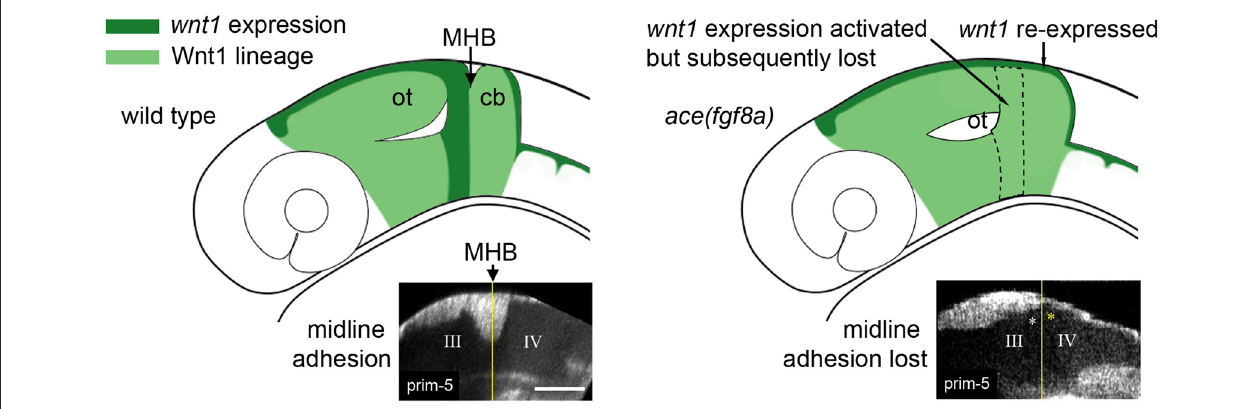
FIGURE 3 | Adhesion failure in ace(fgf8a) embryos and regionally dependent wnt1 lineage response. (Left) Initially broad expression of wnt1 is normally refined to the dorsal midbrain and anterior midbrain hindbrain domain (MH), helping to maintain fgf8a dependent adhesion in the dorsal MH. (Right) wnt1 expression in the posterior midbrain (except for a dorsal stripe) is lost in ace(fgf8a) while wnt1 expression in a dorsal stripe of r1 is reactivated during a cerebellar-to-tectal transformation. Midline adhesion in the MH is not maintained during brain ventricle